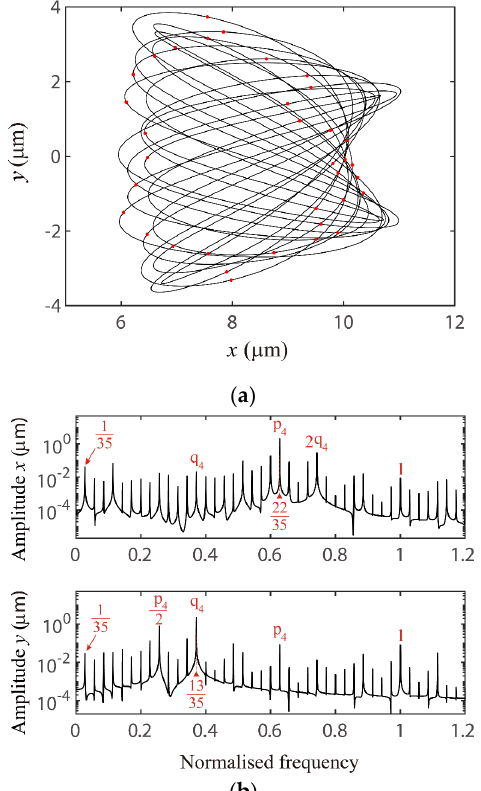
Figure 19. For δ 0 = 4.0 μ m, response characteristics of the VC period-35 motion when Ω = 357 rad/s, ( a ) orbit (black line) and its Poincare mapping (red dots), ( b ) frequency spectrum.